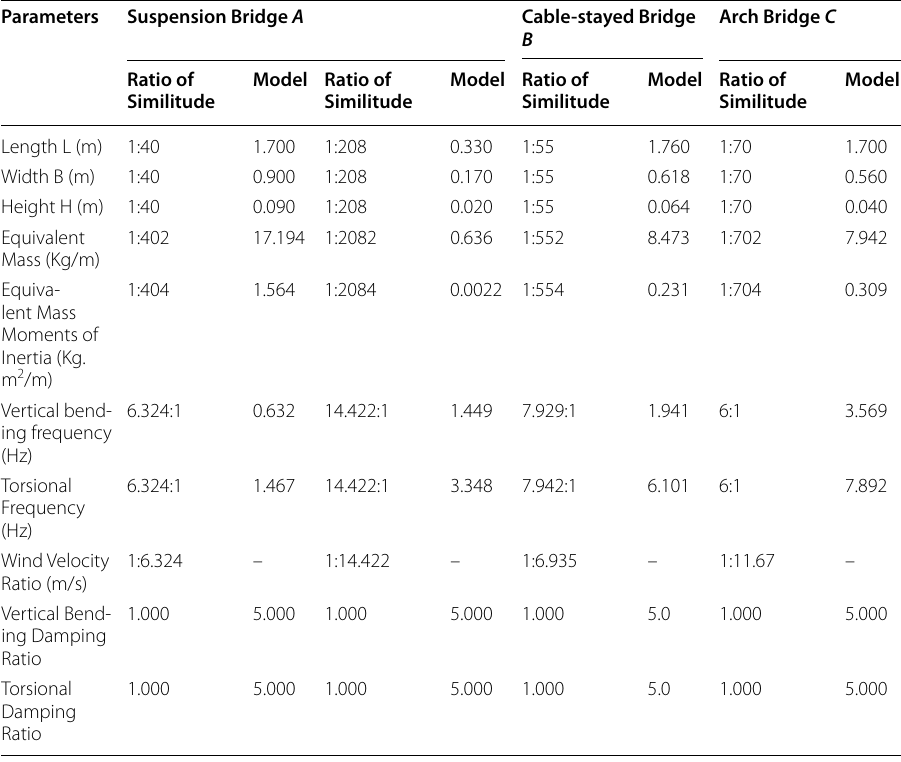
Table 3 Design parameters of the typical large-span bridge segment models Parameters